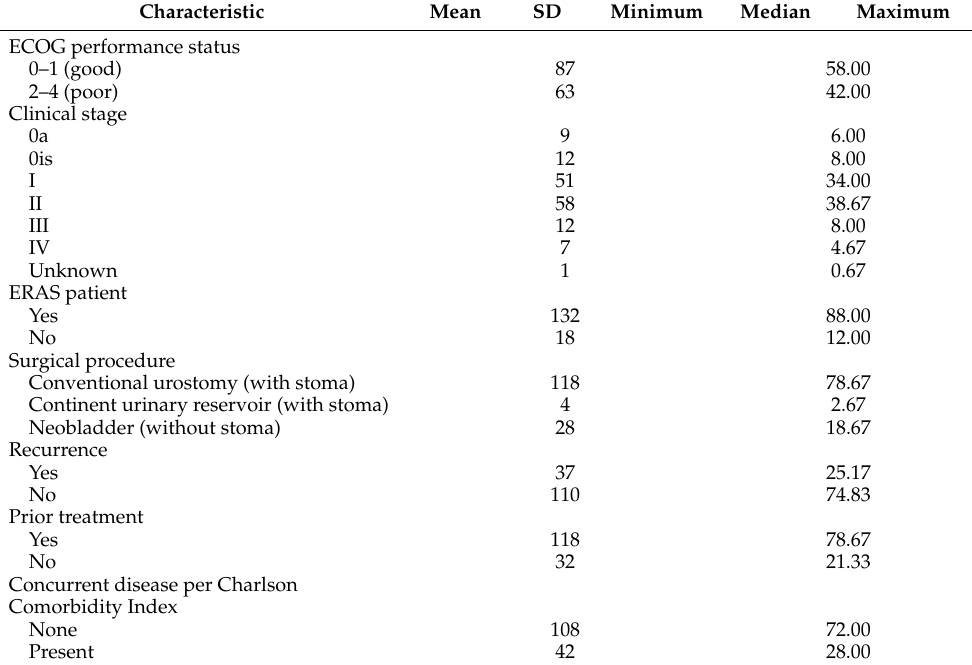
Table 1. Cont. Characteristic Mean SD Minimum